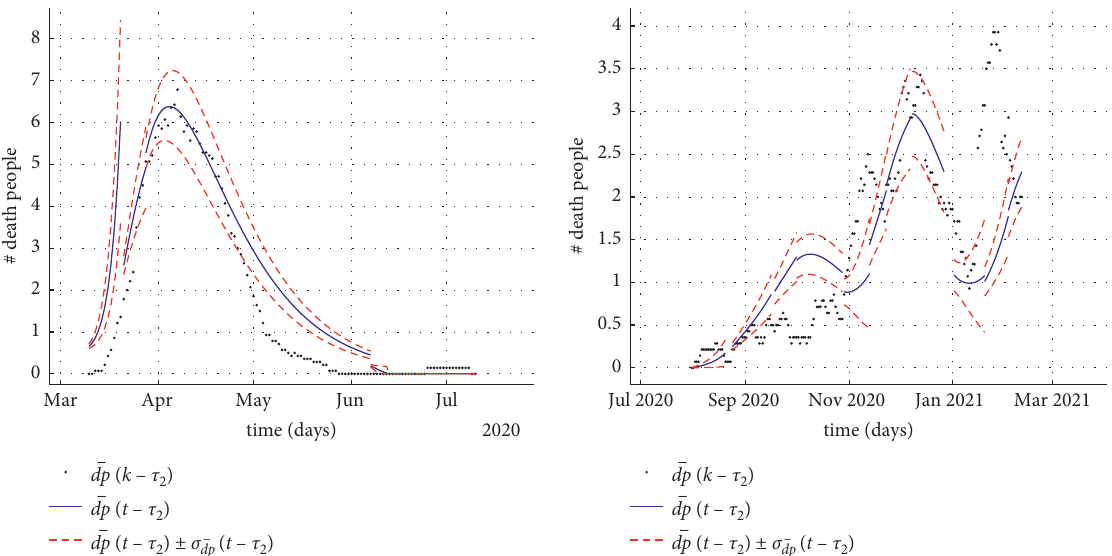
Figure 9: Comparison between measured death people per day (black dots) with respect to the estimation (blue solid line) carried out with the estimated parameters. The dashed red lines show the standard error of the